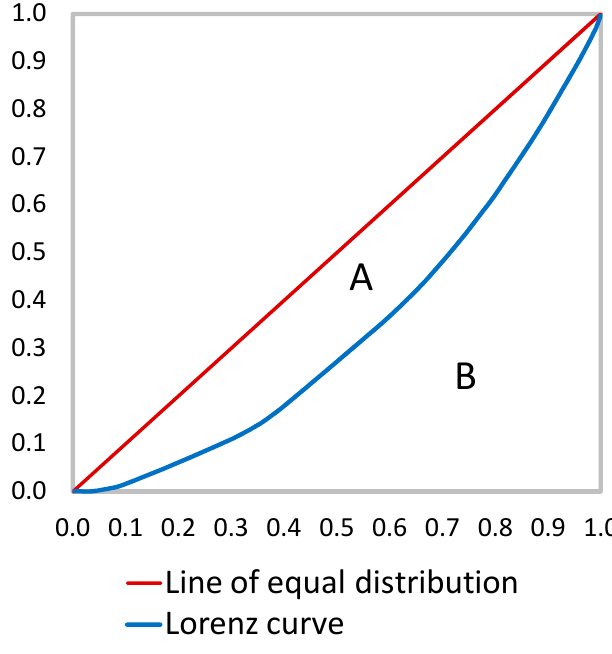
Figure 3. The Lorenz curve and line of equal distribution.